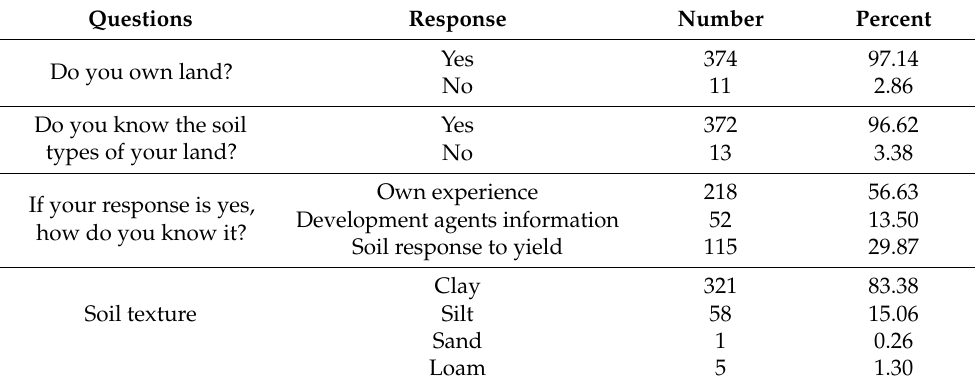
Table 4. HHs perceived soil type in Koga.